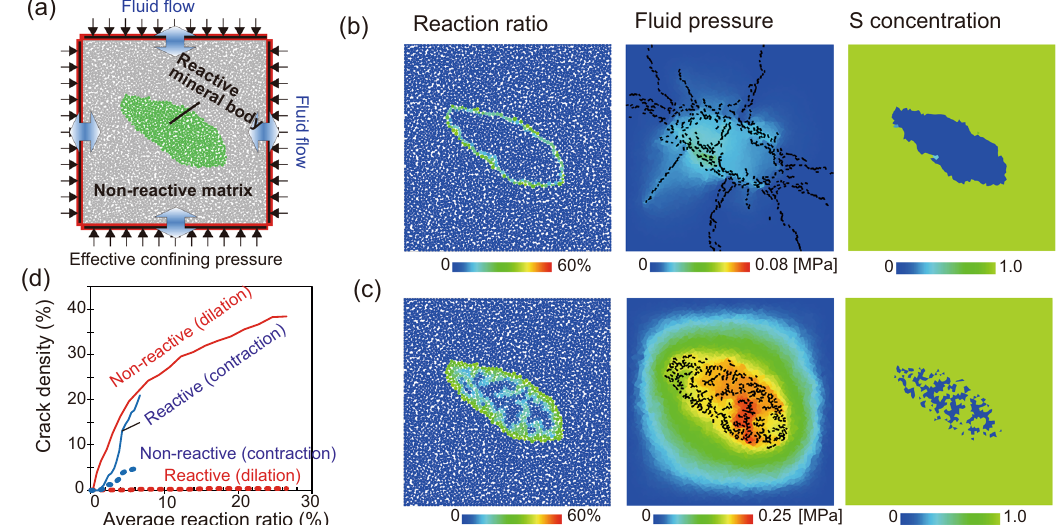
Fig. 5 Representative results of numerical simulations using distinct-element techniques of reaction-induced fracturing during carbonation of a serpentinite body in an non-reactive matrix. a Boundary conditions used in the model. b , c Snapshots of the reaction ratio (left), fl uid pressure distribution ( P f − P min ) with the fracture pattern (middle) and the concentration of species S (right) during reaction progress. b Metasomatic dehydration with dilation at an average reaction ratio, ξ Av = 17.3%, and a volume strain ε v = 0.0076; and c metasomatic dehydration with contraction at ξ Av = 5.5%, and the volume strain ε v = – 0.005. d The crack density (percentage of broken bonds with respect to total bonds) in the reactive material domain and non-reactive matrix for dilation and contraction reactions,